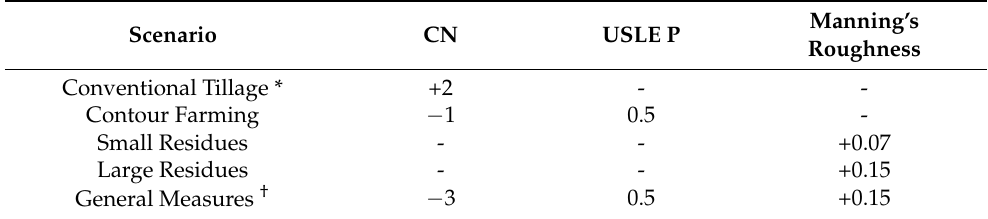
Table 4. Agricultural conservation measures applied to the Nuˇcice Basin and how they are parameter- ized in SWAT. The Soil Conservation Service (SCS) Curve Number (CN) and Manning’s Roughness values represent a relative change from the respective calibrated model [32,33].